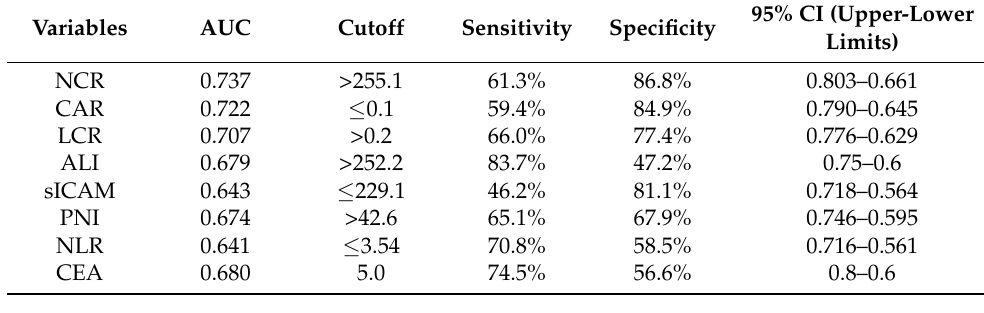
Table 3. Receiver operating characteristic (ROC) curve analysis to evaluate the predictive value of inflammatory biomarkers for OS in the discovery cohort.